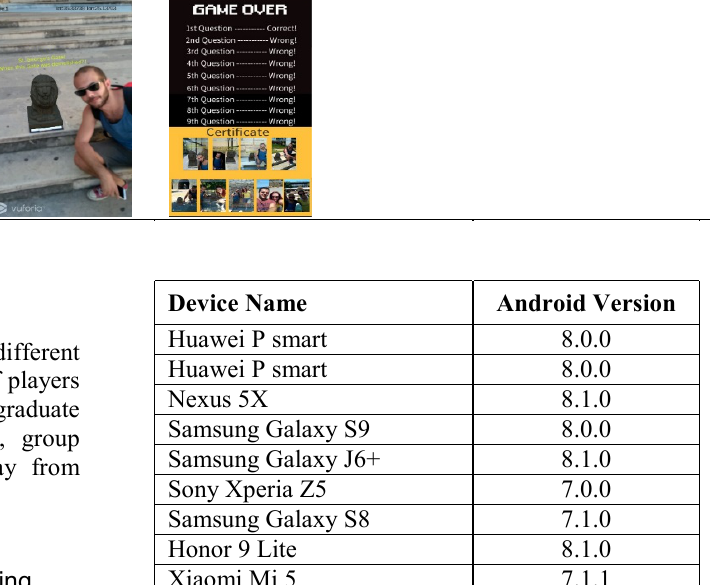
Table 1. List of mobile devices used for testing